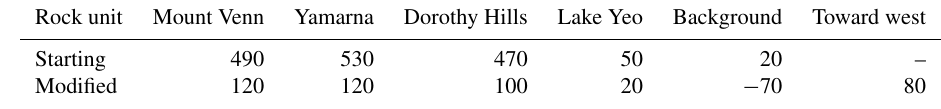
Table 1. Density contrasts assigned to different rock units (units: kgm − 3 ).